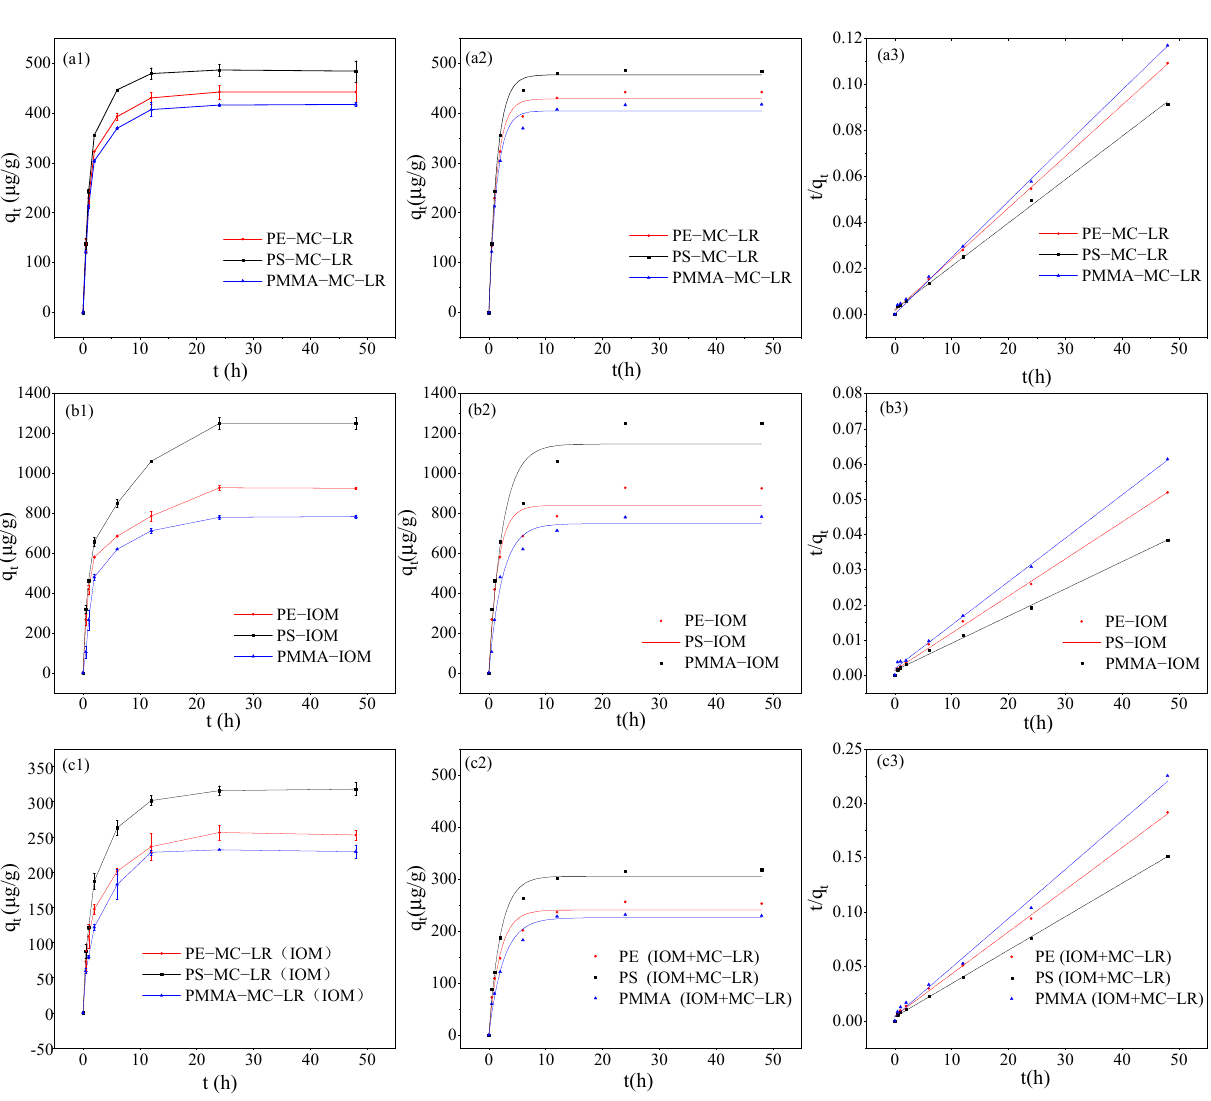
Figure 2. Isothermal adsorption model fitting curves for MC-LR ( a ), IOM ( b ), and MC-LR adsorp- tion in the presence of IOM ( c ) on PE, PS, and PMMA. 3500 3000 2500 2000